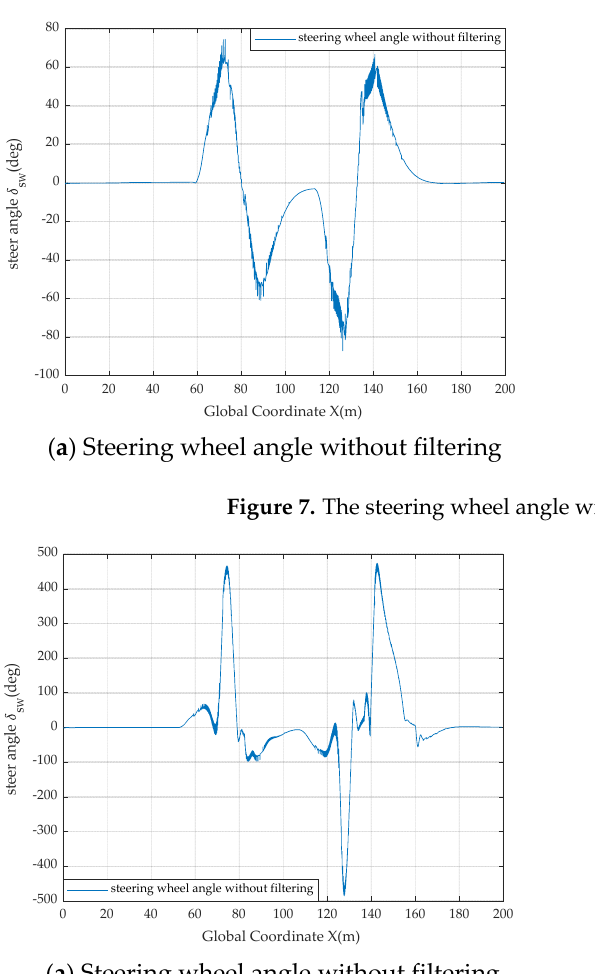
( b ) Steering wheel angle with filtering Figure 8. The steering wheel angle with and without filtering at RAC = 0.5 and VS = 20 m/s. These results above show that the filter is highly effective in reducing and even elim ‐ inating jitter caused by the controller.